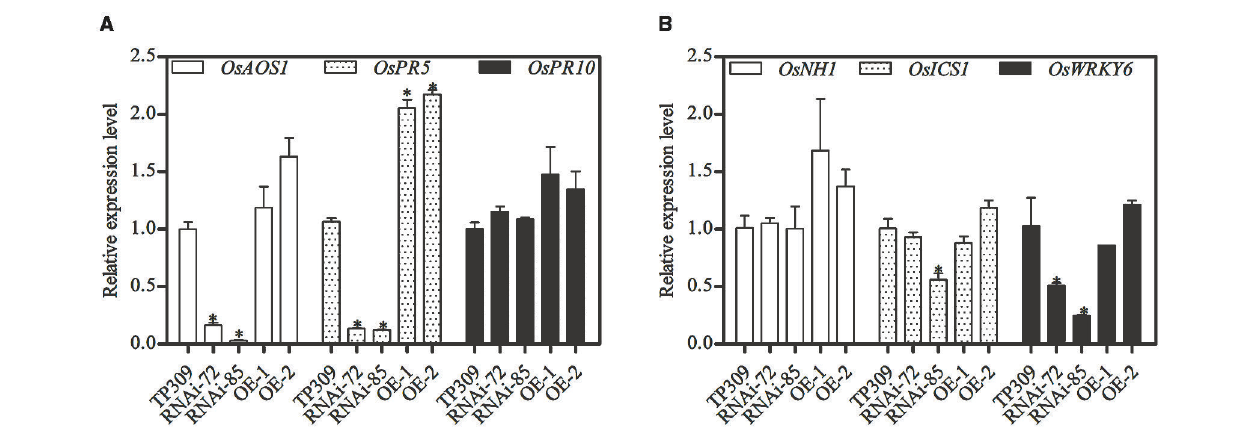
FIGURE 7 | Relative expression of OsPRs in transgenic lines determined by qPCR with an SYBR® Premix Ex Taq TM II Kit. The transcript levels of PR genes in WT were considered 100%. Expression levels of the target gene were normalized to the ACTIN reference gene. (A) Relative expression of OsAOS1 , OsPR5 , and OsPR10 . (B) Relative expression of OsNH1 , OsICS1 , and OsWRKY6. Each value represents the mean ± SE of three biological replicates. Asterisks indicate significant differences compared to TP309 ( P < 0.05) by one-way ANOVA followed by Tukey’s HSD analysis. The error bars indicate the standard errors. Three independent experiments were performed with similar results. qPCR, quantitative PCR; WT, wild type.